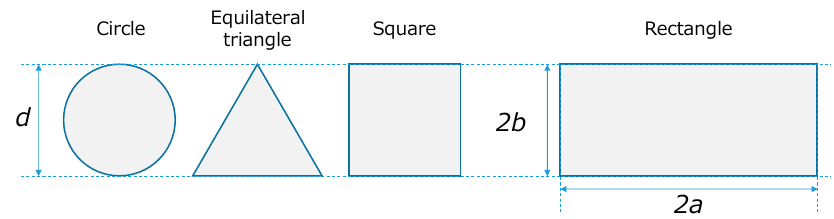
Figure 3. Channel’s cross-section and size of each duct shape. A list of parameters related to each flow path shape is shown in Table 1 (Müller showed not only each friction factor, but also analytical velocity distribution and volumetric flow rate [33]). Table 1. Parameters regarding pressure drop of each cross-sectional shape.